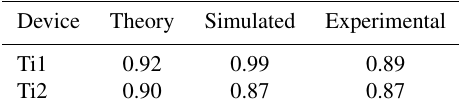
Table 6. A comparison of the average thermal coupling coefficient, β 12 , of the devices under vacuum conditions.